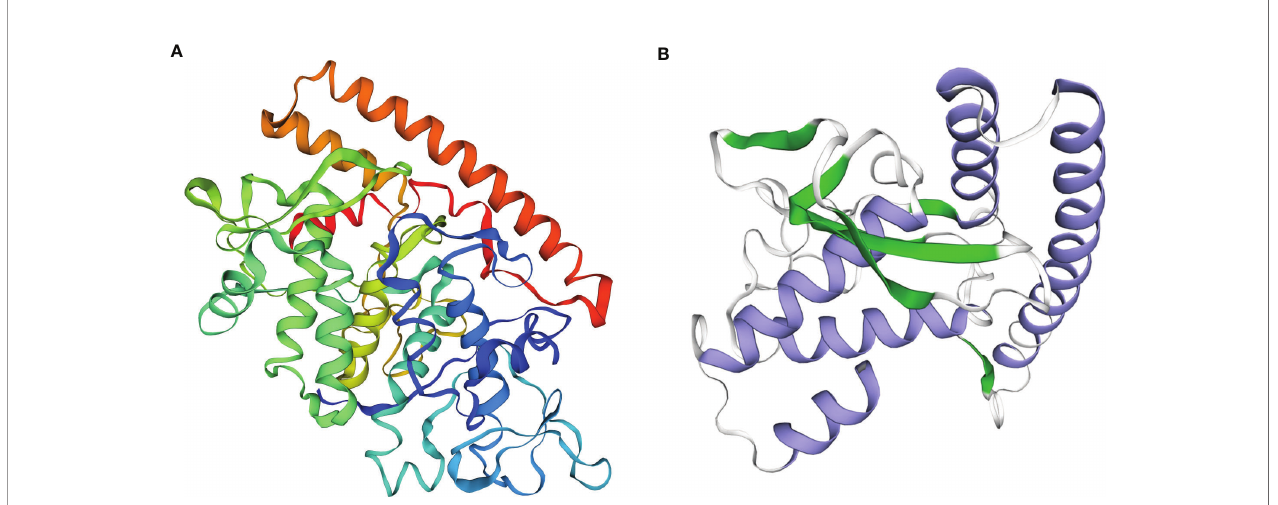
FIGURE 1 | Function and structure predicted of the GCRV VP6. (A) Analysis of functional domains of the GCRV VP6. (B) Structure prediction of the N-terminal of the GCRV